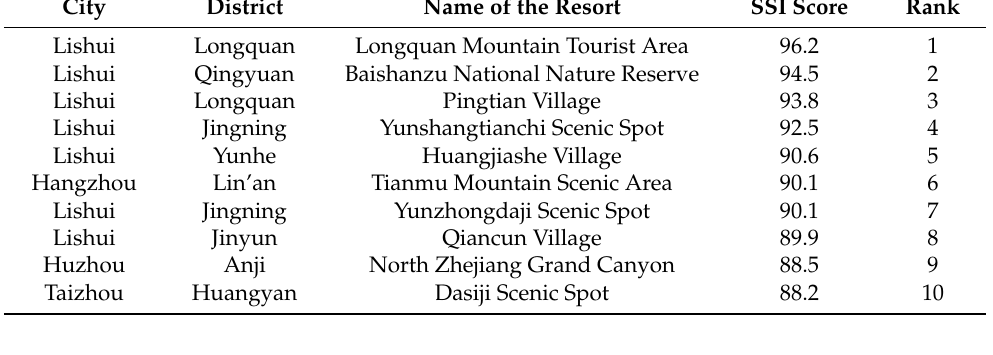
Figure 3. Distribution of VCI in Zhejiang Province (Unit: %).